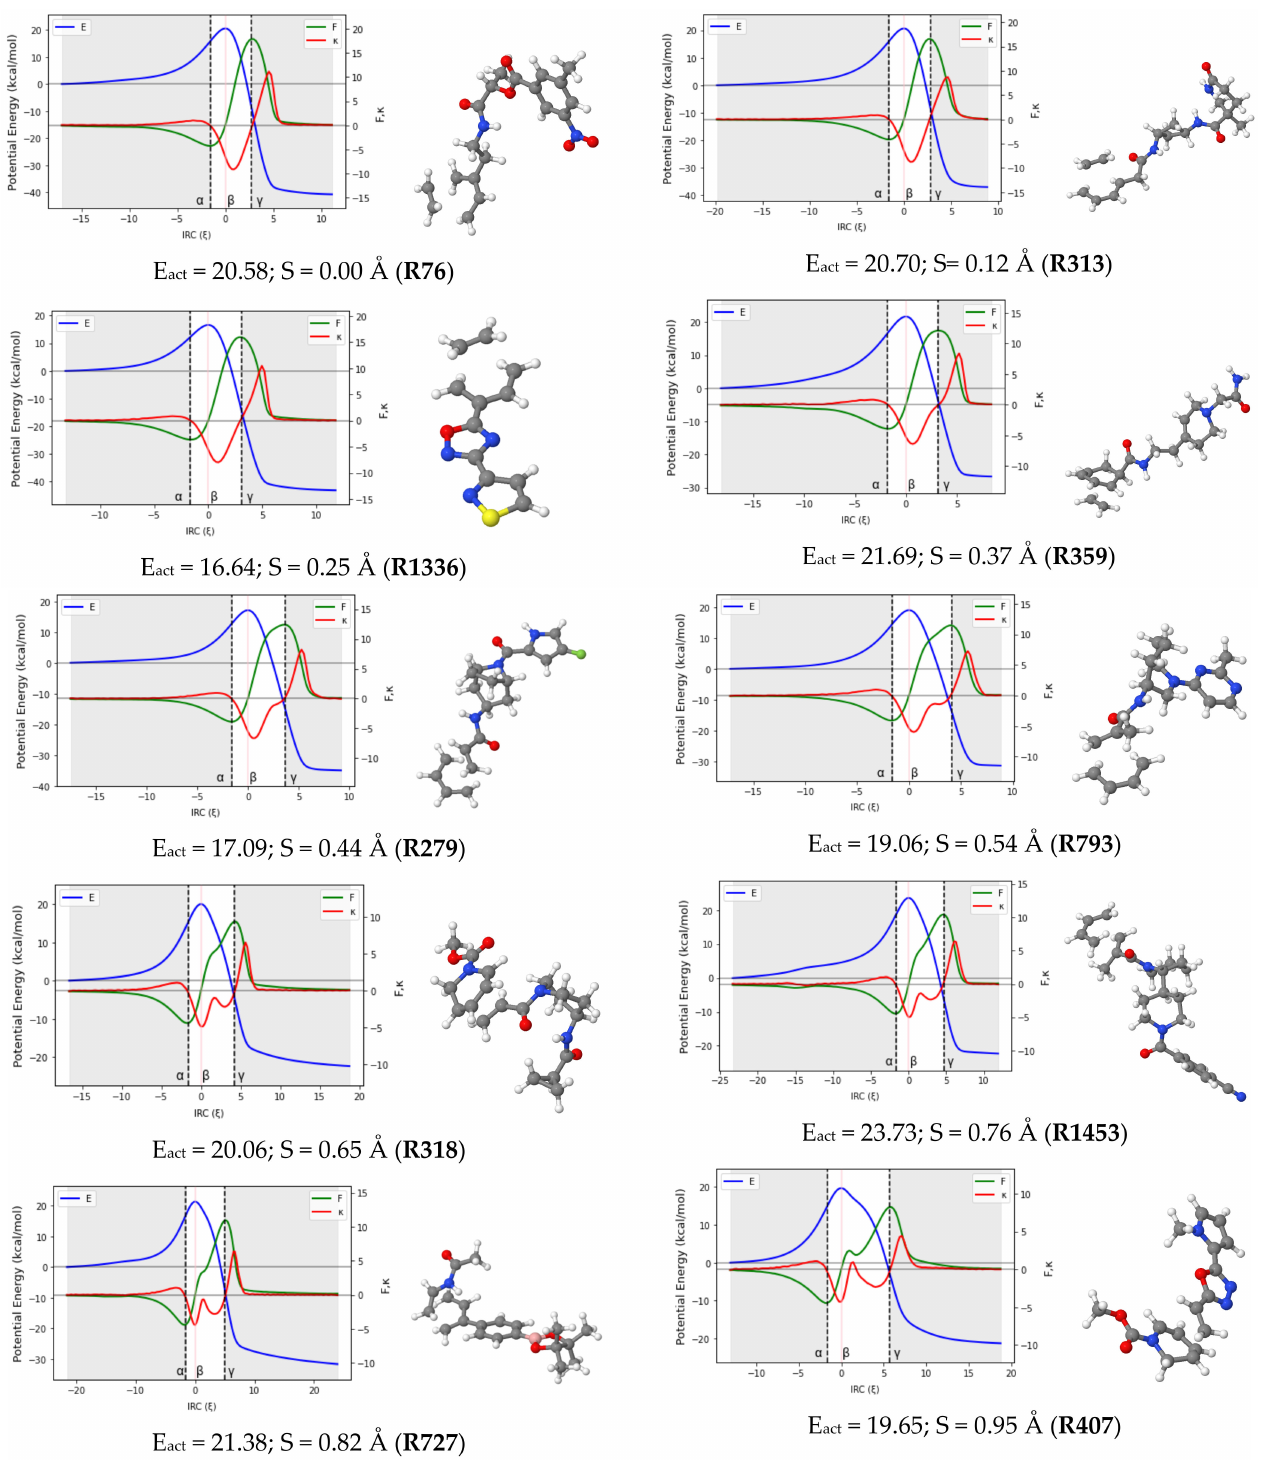
Figure 3. RFA plots for a representative set of ten DA reactions. TSs structures, activation energy and synchronicity of the corresponding reactions are also given. Each reaction is identified by its ID in line with the